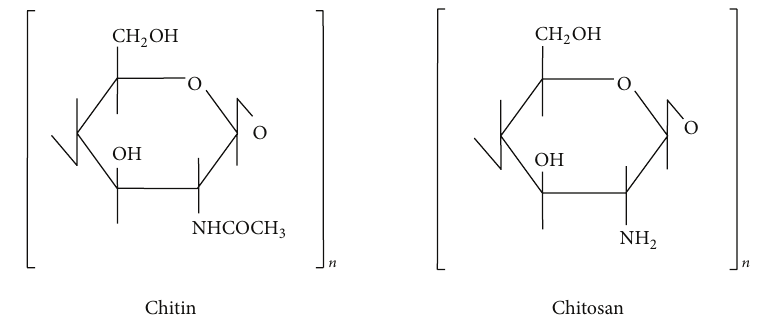
Figure 1: Chemical structure of chitin and